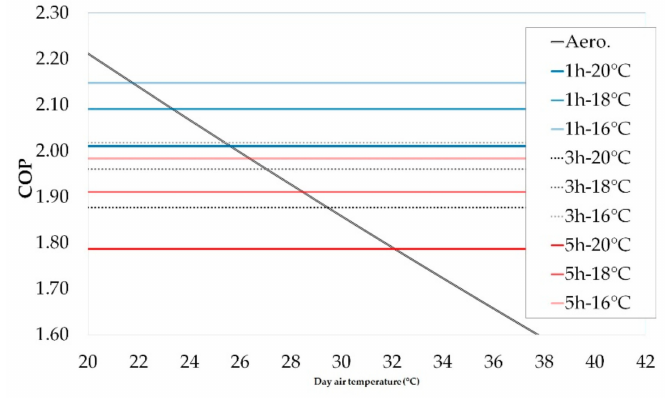
Figure 14. COP of the PCM mode and the aerothermal mode for di ff erent use and temperature